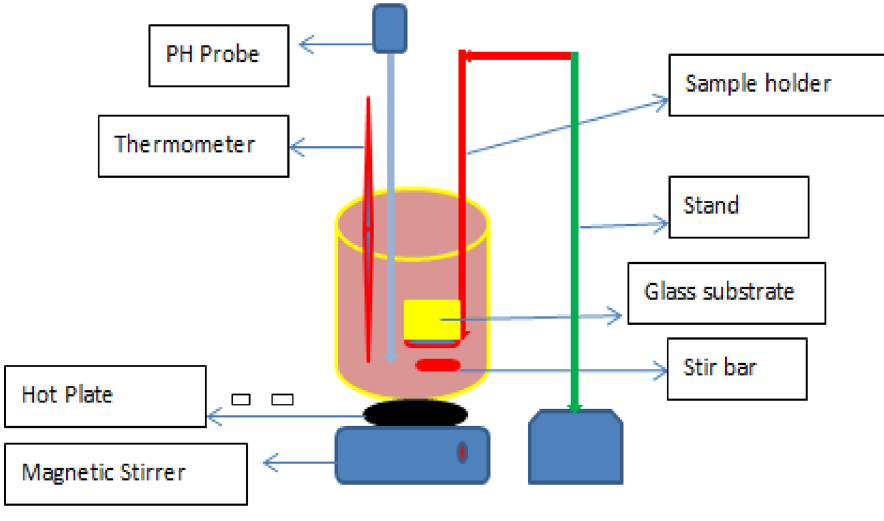
Figure 1. A schematic set of CBD method.